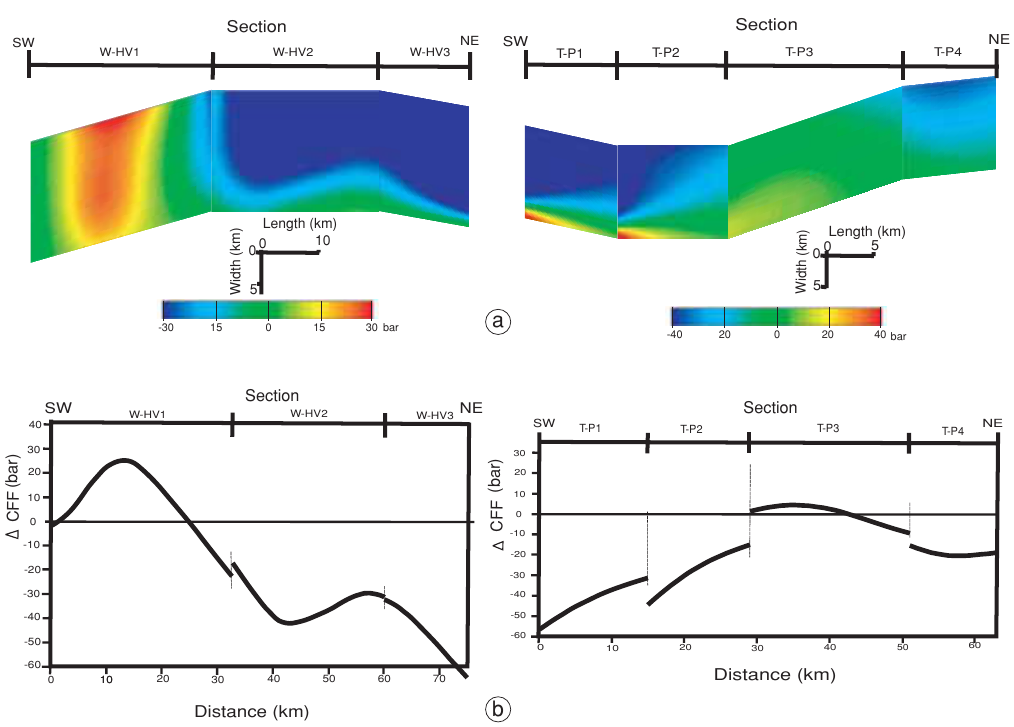
Fig. 8a,b. The distribution of (cid:54) CFSs for the flexed Wairarapa Fault. a) The distribution of (cid:54) CFSs on the fault planes of the W-HV and T-P segments. b) The distribution of (cid:54) CFSs at the mid-seismogenic depths of 10